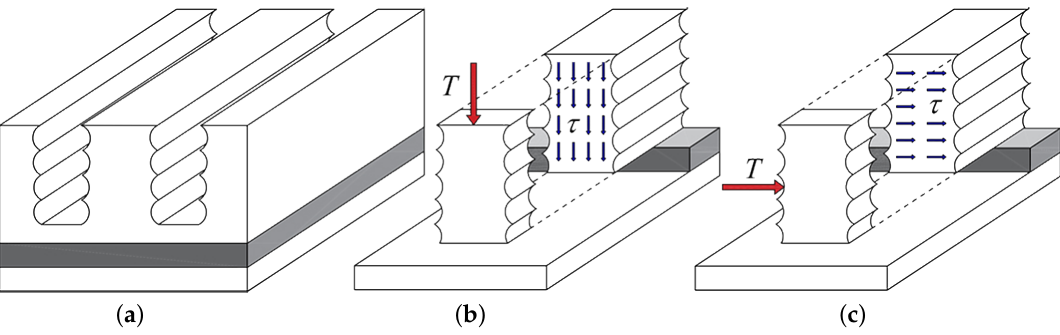
Figure 2. A simplified representation of the SOI wafer after four cycles of the D-RIE process ( a ), and of a cantilever beam after oxide wet etching, subject to out-of-plane ( b ) and in-plane ( c ) shear tension.